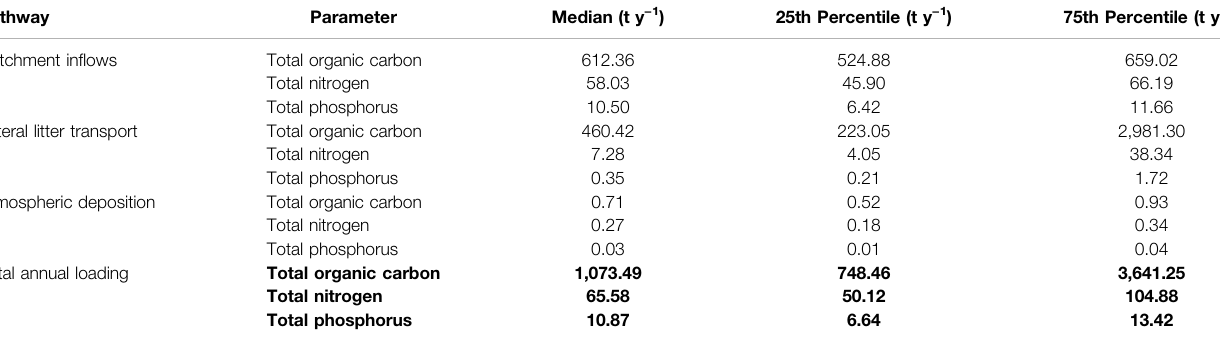
TABLE 4 | Annual macronutrient loading to Little Nerang Dam reservoir from three pathways: catchment in fl ow; lateral litter transport; and atmospheric deposition. Pathway Parameter Catchment in fl